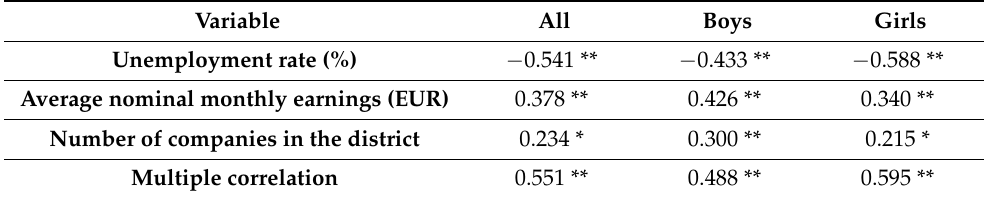
Table 3. Results of correlation analyses between SEIs and overall MP (T-scores), and of multiple correlations, at the level of